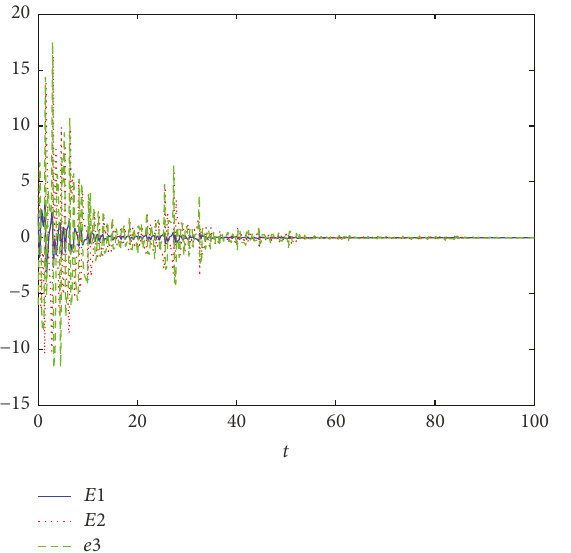
Figure 4: Get the error system asymptotically stable with controller = (𝑝 𝐸 ,0,0) 𝑇 . 𝑈 2 1 1